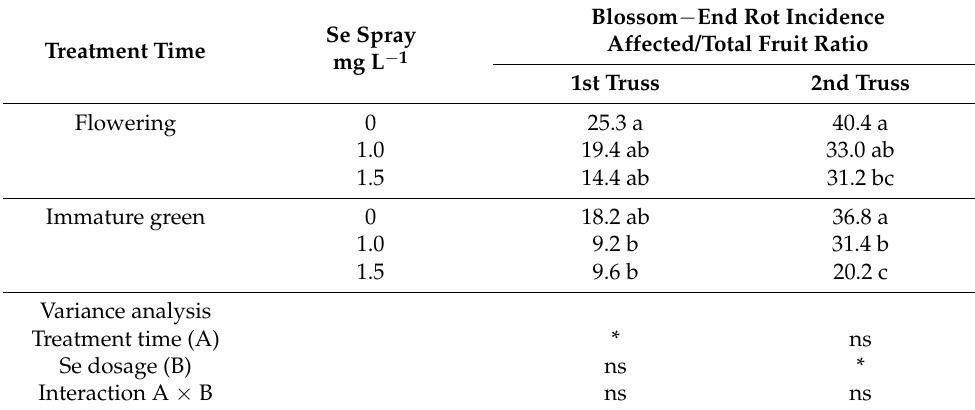
Table 4. Incidence of blossom-end rot on fruits of plants treated with sodium selenate (Na 2 SeO 4 ), at different selenium concentrations and distributed at FL and fruit IG